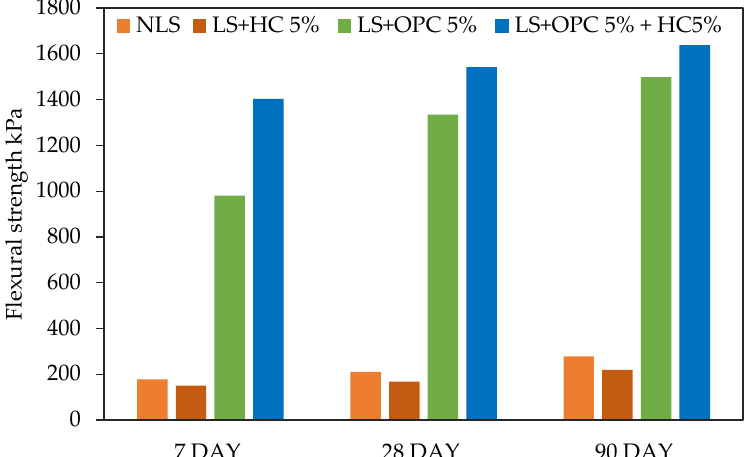
Figure 5. Flexural load–deflection curves of the treated and untreated test samples after 7, 28, and 90 days of curing.